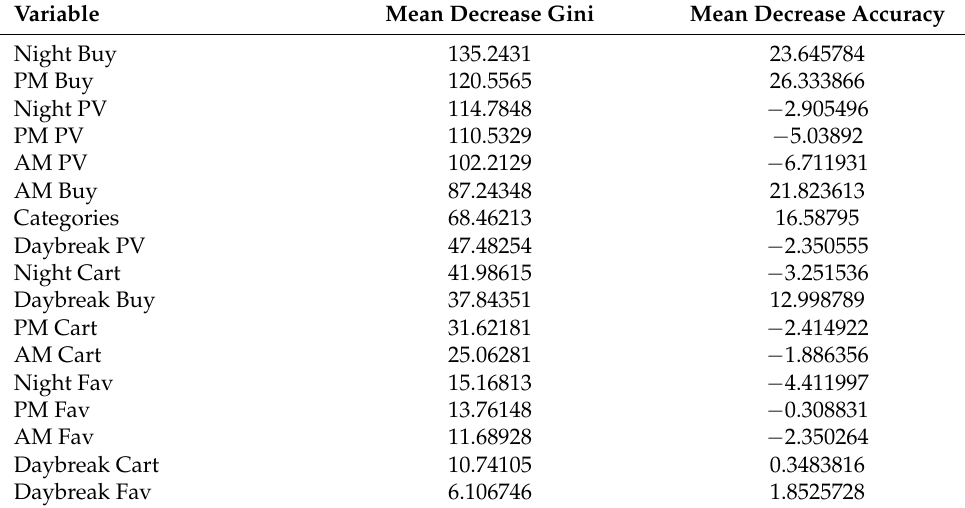
Table 3. Importance of random forest variable selection.